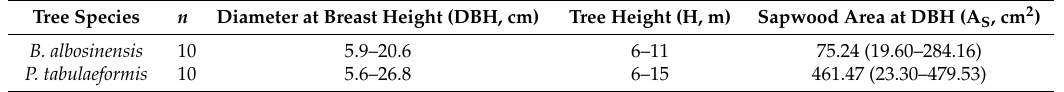
Table 1. Characteristics of study trees and sites. Values given in the parentheses are the range in diameter at breast height (DBH, cm), and sapwood area at DBH. After extraction of the wood core with Haglof Increment Borer, the sapwood area was estimated by dyeing the wood core. Tree Species n Diameter at Breast Height (DBH, cm) Tree Height (H, m) Sapwood Area at DBH (A S , cm 2